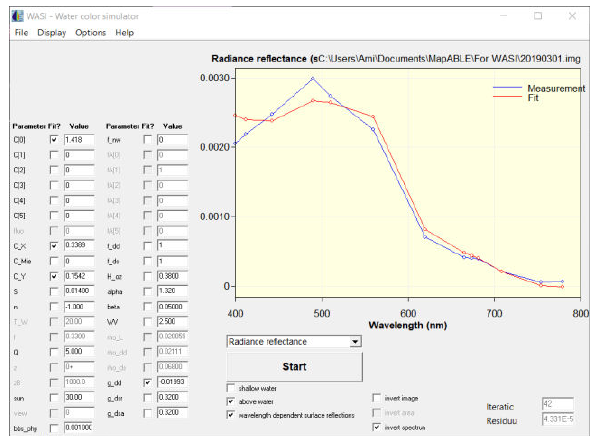
Figure 1 . Sentinel-3 Bio-optical Water Quality Inversion through the Water Color Simulator (WASI)